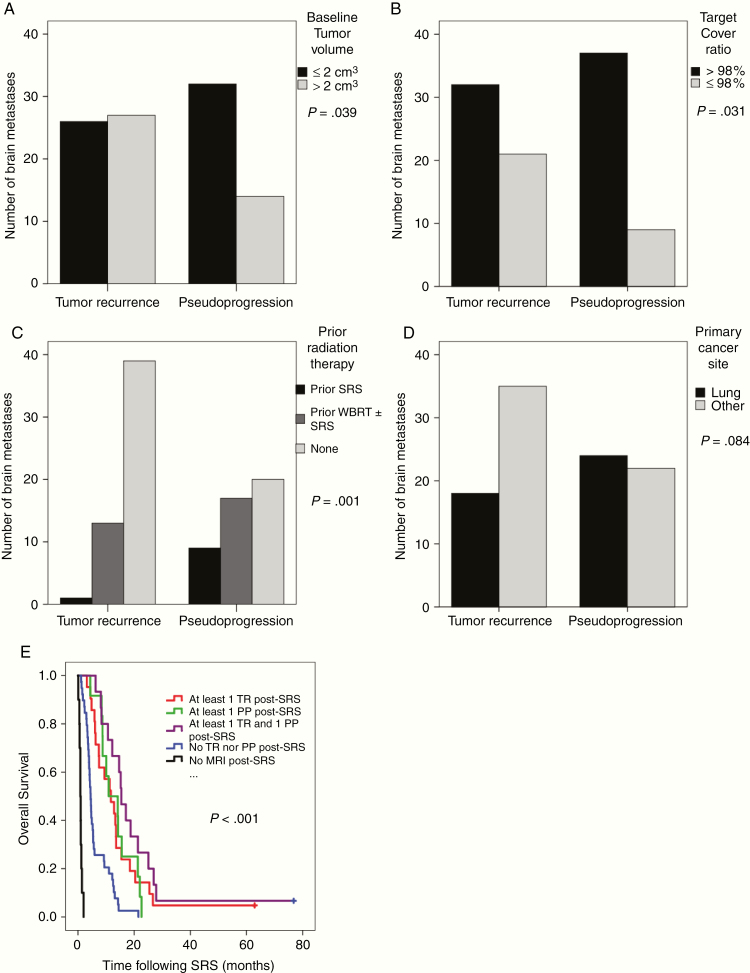
The number of brain metastases (BM) that responded to stereotactic radiosurgery (SRS) with pseudoprogression or tumor recurrence with: (A) Baseline volume ≤2 cm3 vs. >2 cm3. (B) Target cover ratio at SRS <98% vs. ≥98%. (C) Prior treatment with SRS, whole brain radiotherapy ± SRS vs. no prior radiation treatment. (D) Primary lung cancer origin vs. other origin than lung cancer. (E) Overall survival curves for patients with (a) at least 1 BM that recurred (TR) (red), (b) at least 1 BM that pseudoprogressed (PP) (green), (c) a mixture of TR and PP (violet), (d) no TR nor PP (blue), and (e) no follow-up images (black).